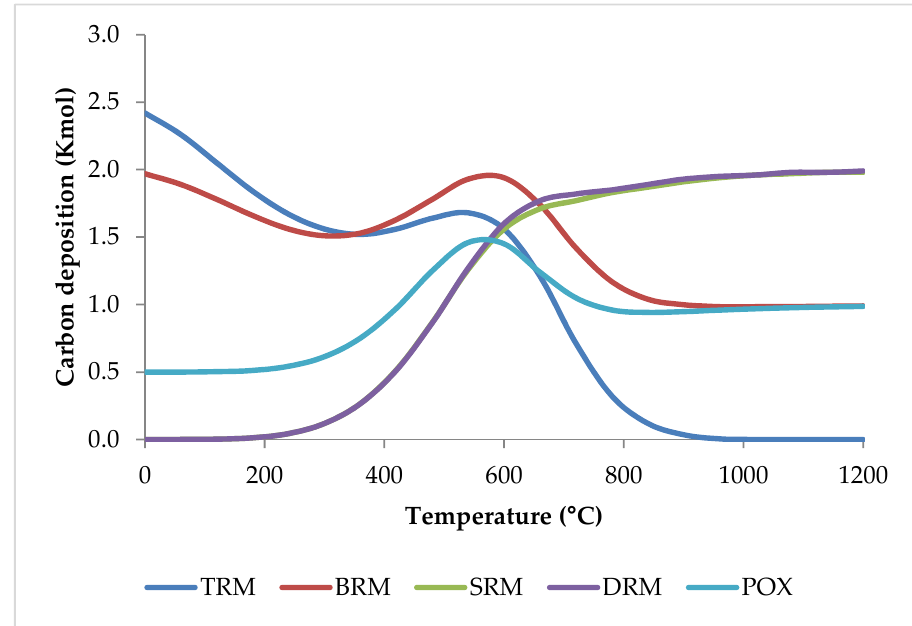
Figure 16. Coke formation versus temperature for different reforming methods based on equilibrium conditions simulated by HSC software.